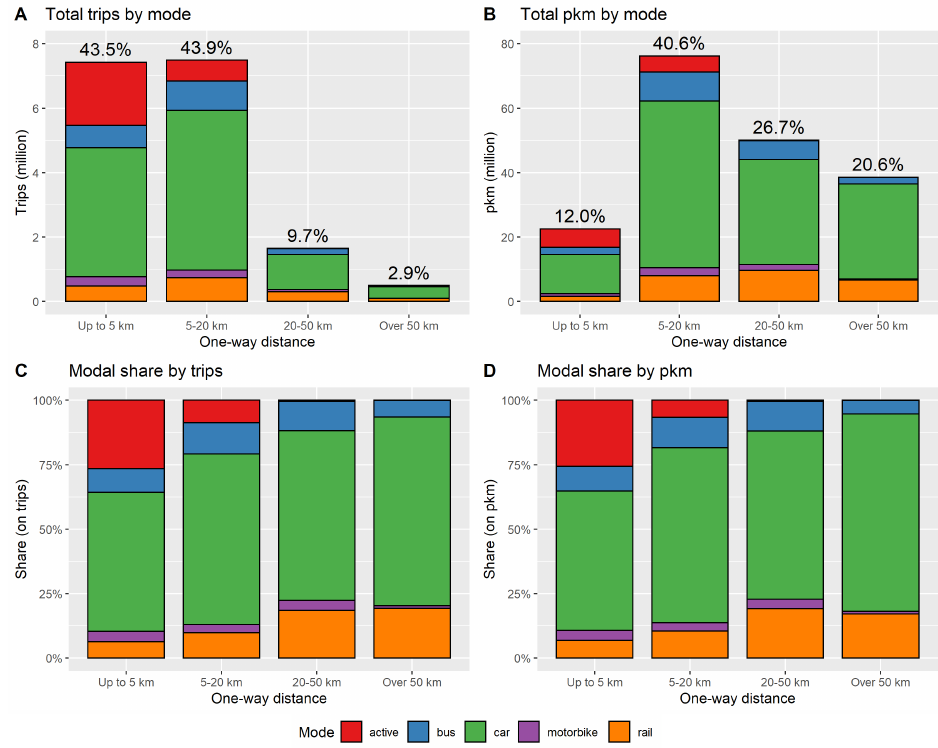
Figure 2. Statistics on daily trips by mode in Lombardy. Total trips by mode ( A ), total pkm by mode ( B ), modal share by trips ( C ), and modal share by pkm ( D